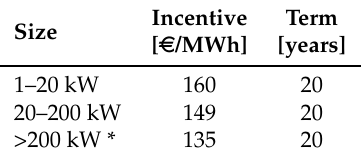
Table 4. Self-consumption tariffs for PV plants using innovative technology established in [63].